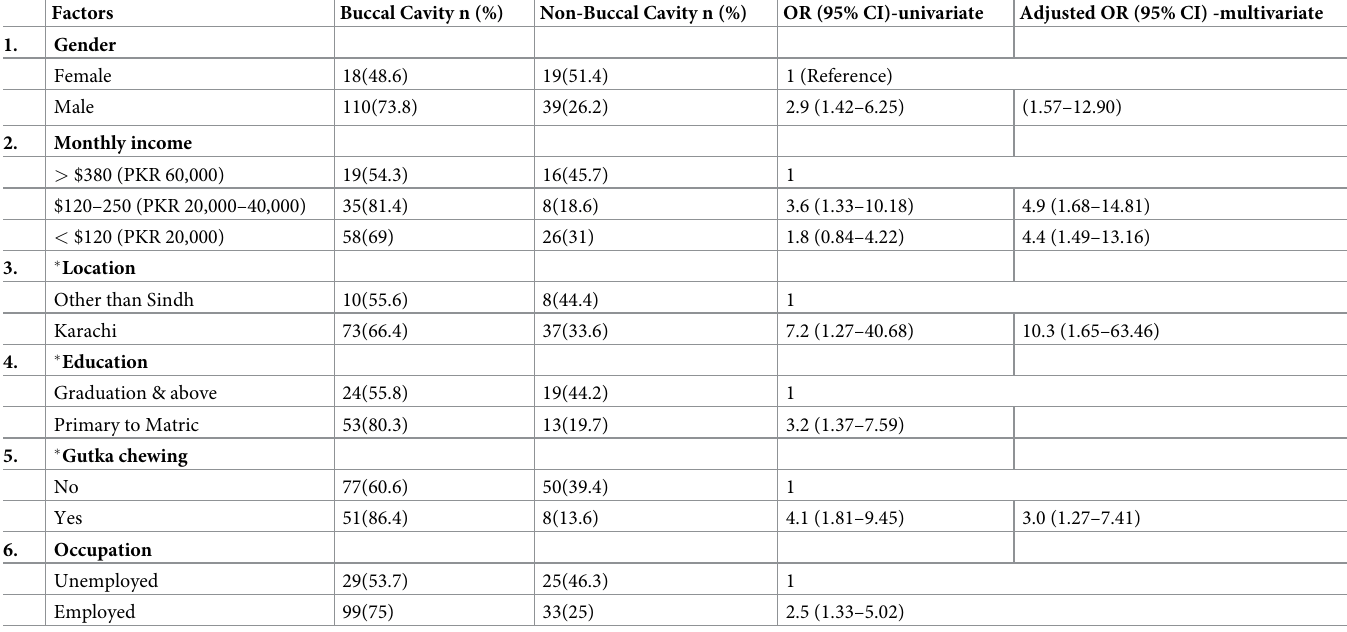
Table 3. Model 2, univariate and multivariate regression analysis of SES variables with tumor site as dependent variable in OSCC patients. Factors Buccal Cavity n